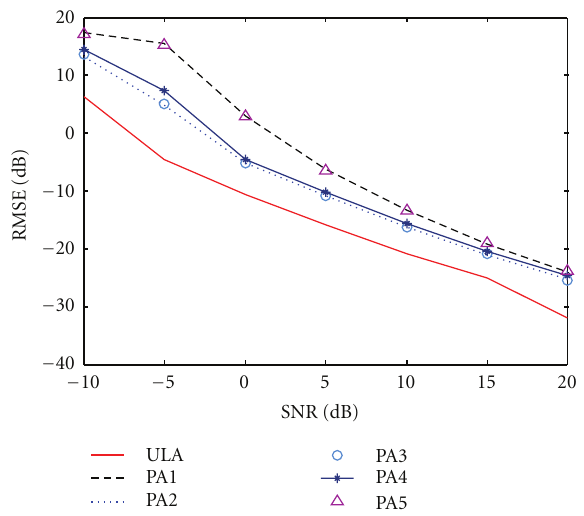
Figure 7: Total RMSE of the MVDR algorithm for di ff erent configurations where signals are arriving at endfire directions.